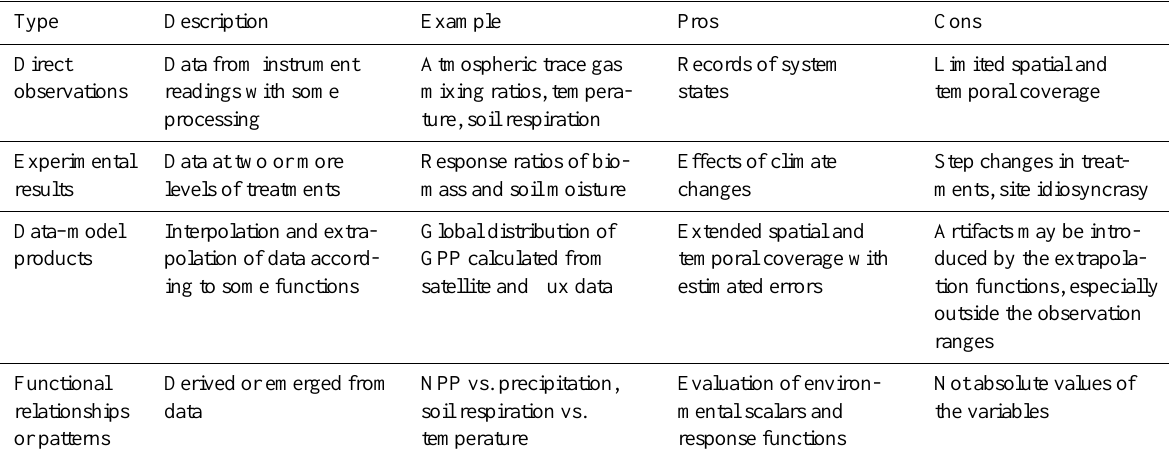
Table 1. Types of benchmarks to be used for evaluating model